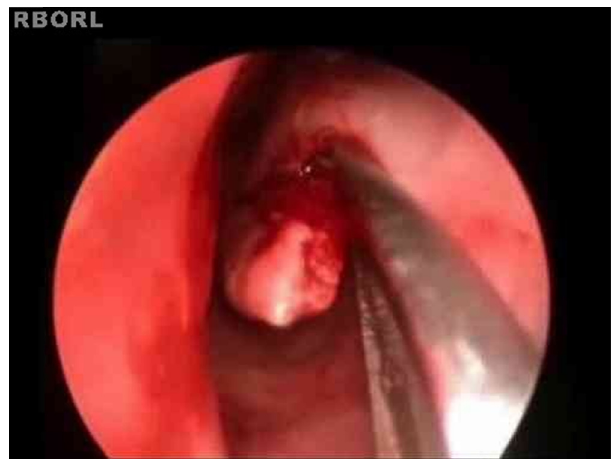
Removal of bony spicule using a